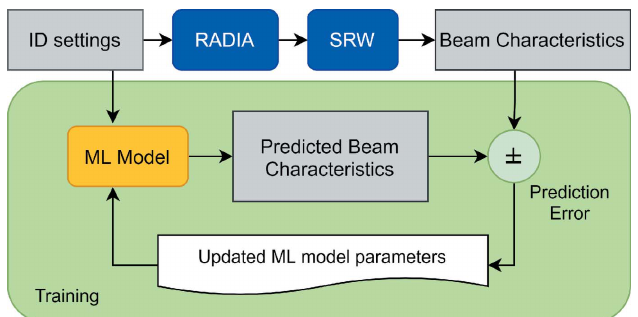
Figure 5 The procedure for training an ML model using the physics simulation as the ground truth (Edelen et al. , 2020). The ML model parameters are dynamically updated during training. The hyperparameters of the model are manually adjusted until the model reaches a target performance.